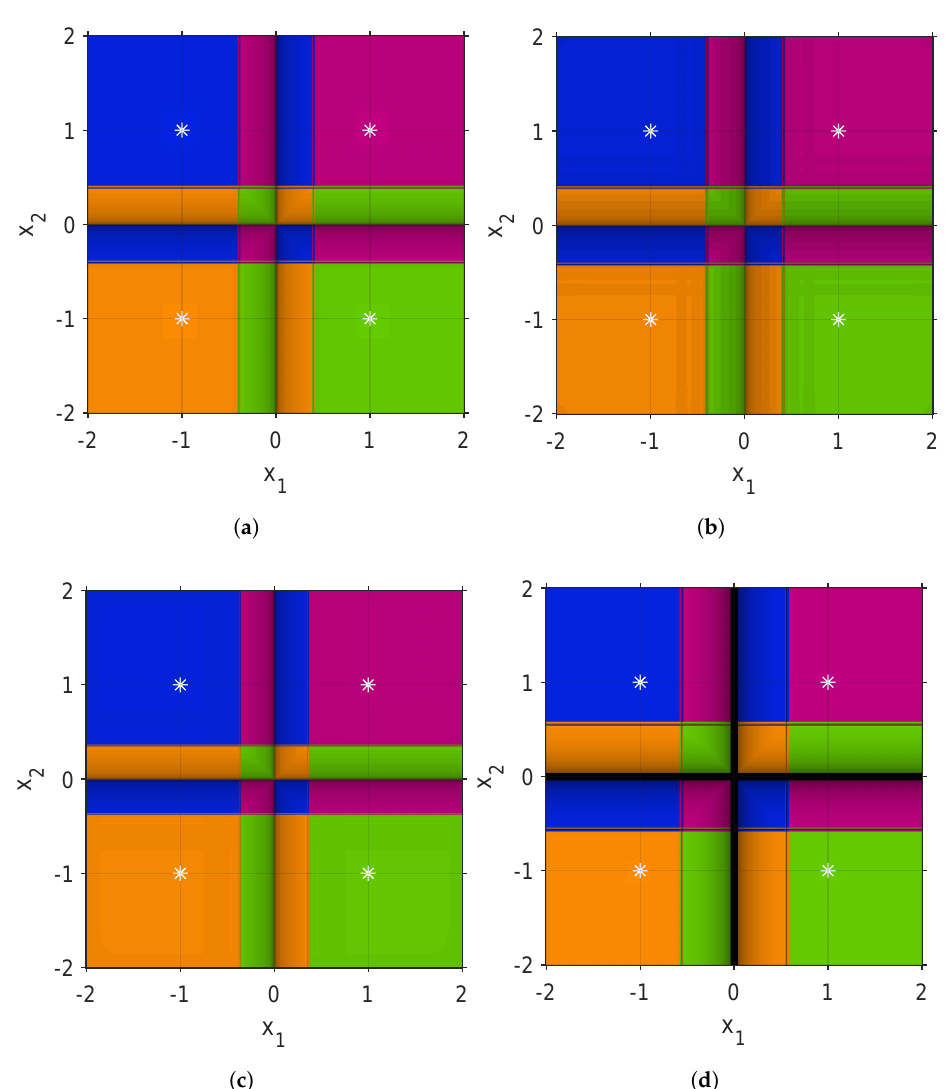
Figure 5. Dynamical planes of solving system (20) with the methods ( a ) AC, ( b ) FS1, ( c ) FS2, and ( d )